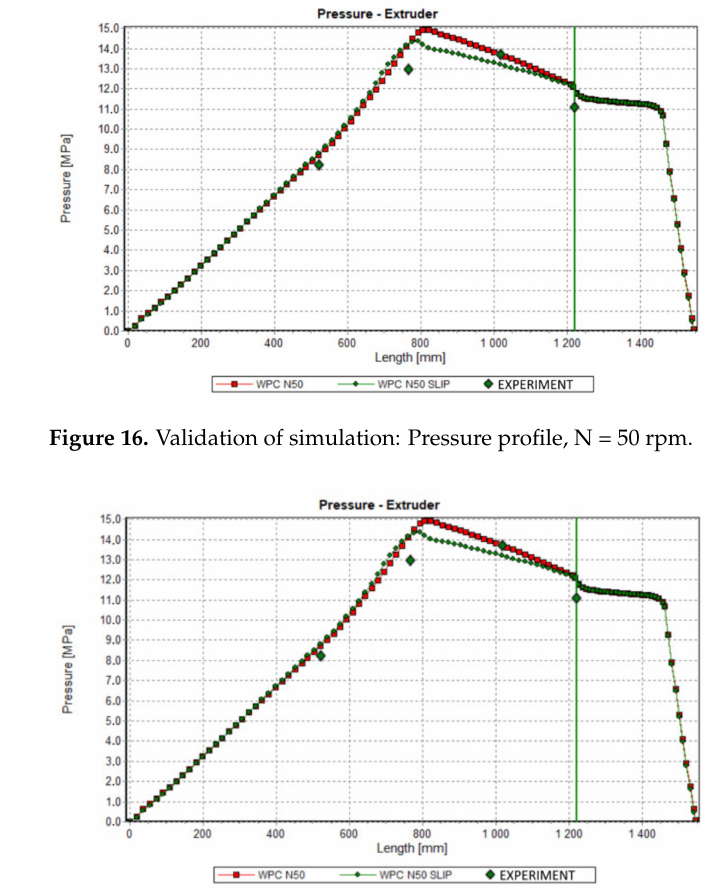
Figure 17. Validation of simulation: Pressure profile, N = 80